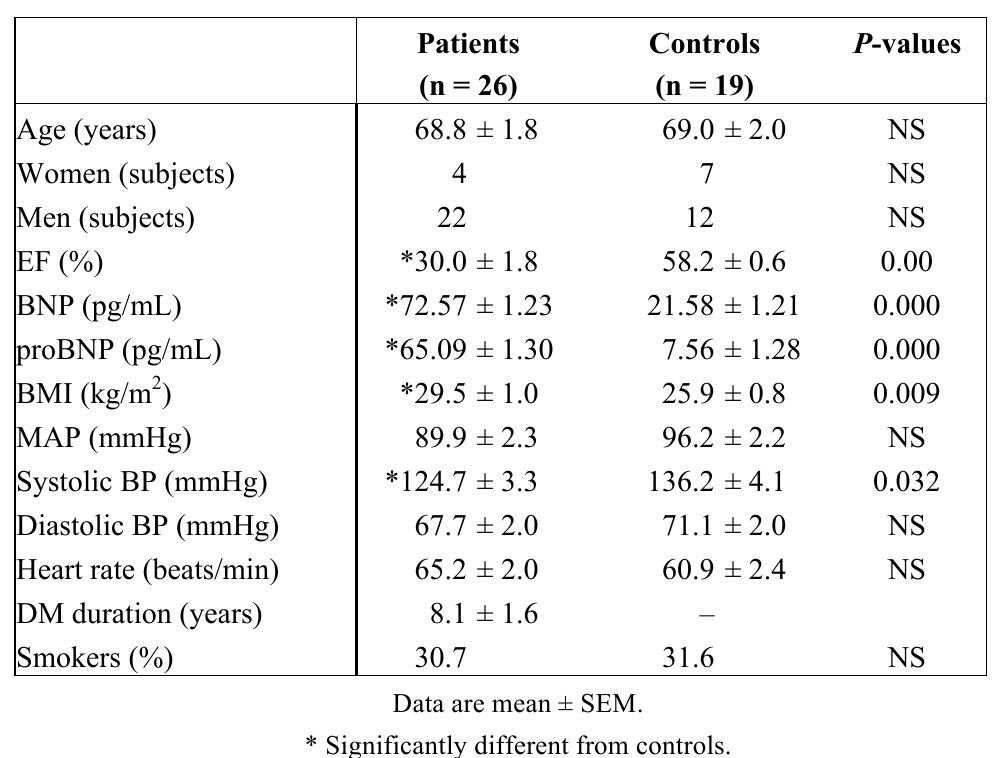
Table 1. Characteristics of patients and controls.